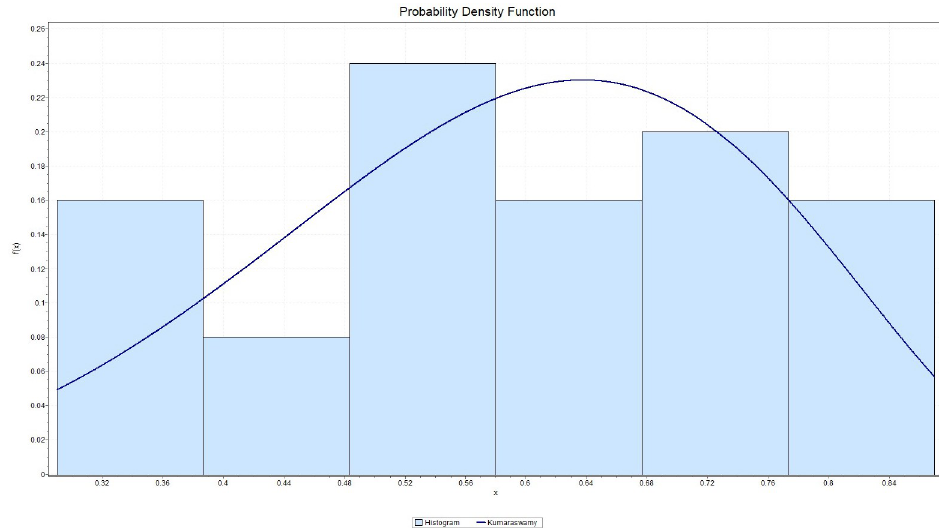
Fig 9. The histogram of the data set and its fitted density function of the patient relief times.